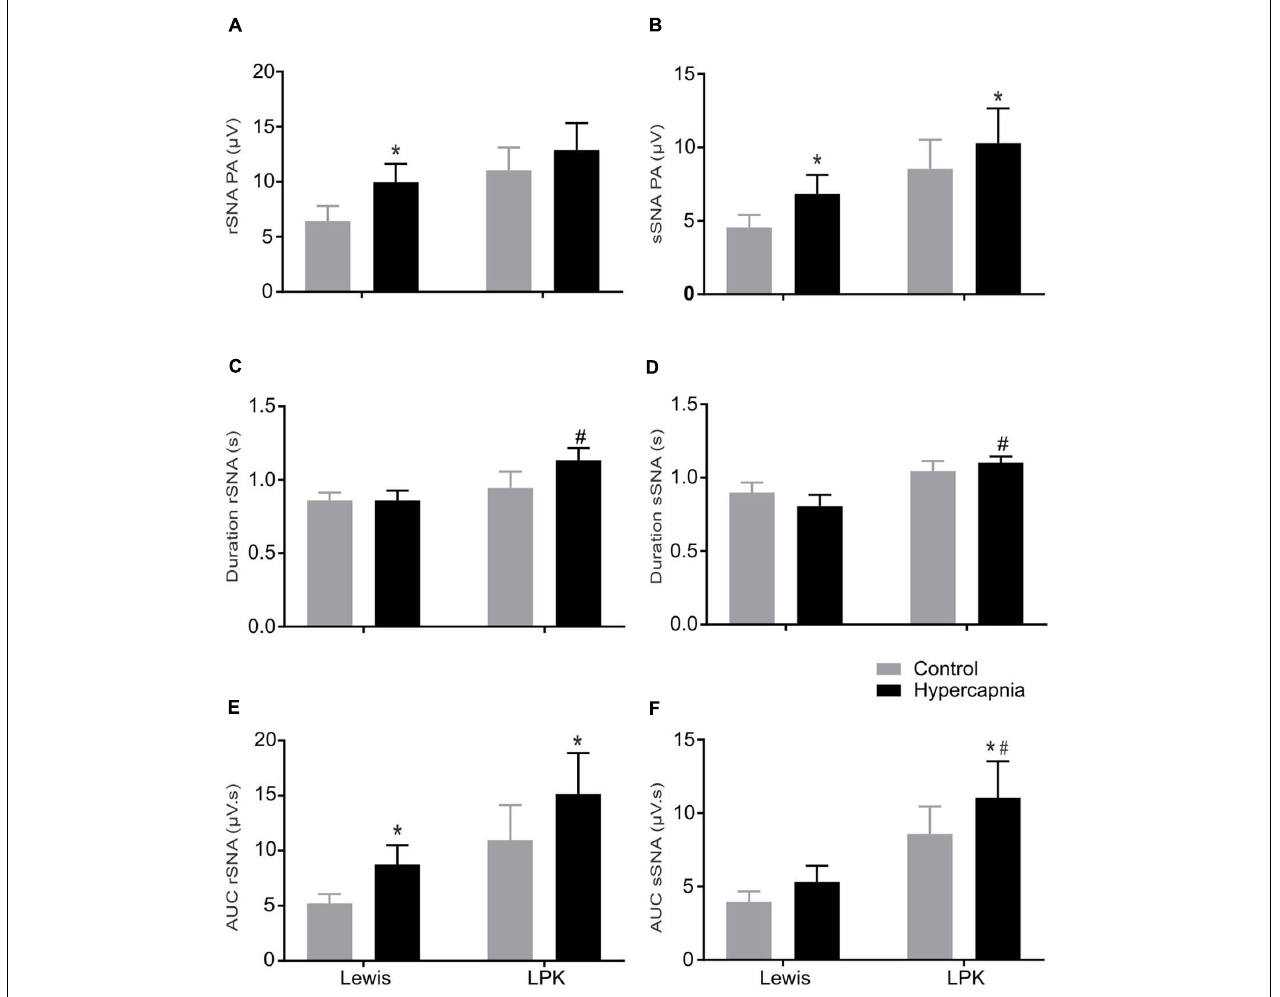
FIGURE 5 | The effect of hypercapnia on respiratory-related sympathetic nerve activity in adult female Lewis and LPK rats: group data. Respiratory-related sympathetic nerve activity measured as peak amplitude (A,B) , duration (C,D) , or area under the curve (AUC; E,F ) of the phrenic triggered R rSNA (A,C,E) and R sSNA (B,D,F) during normoxia (control) and hypercapnic conditions. Data are expressed as mean ± SEM n ≥ 5 per group. * P < 0.05 hypercapnia versus control within each strain; # P < 0.05 LPK versus treatment-matched Lewis.